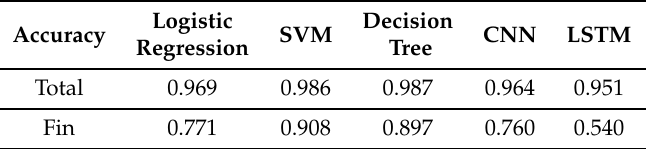
Table 9. Classifier accuracy